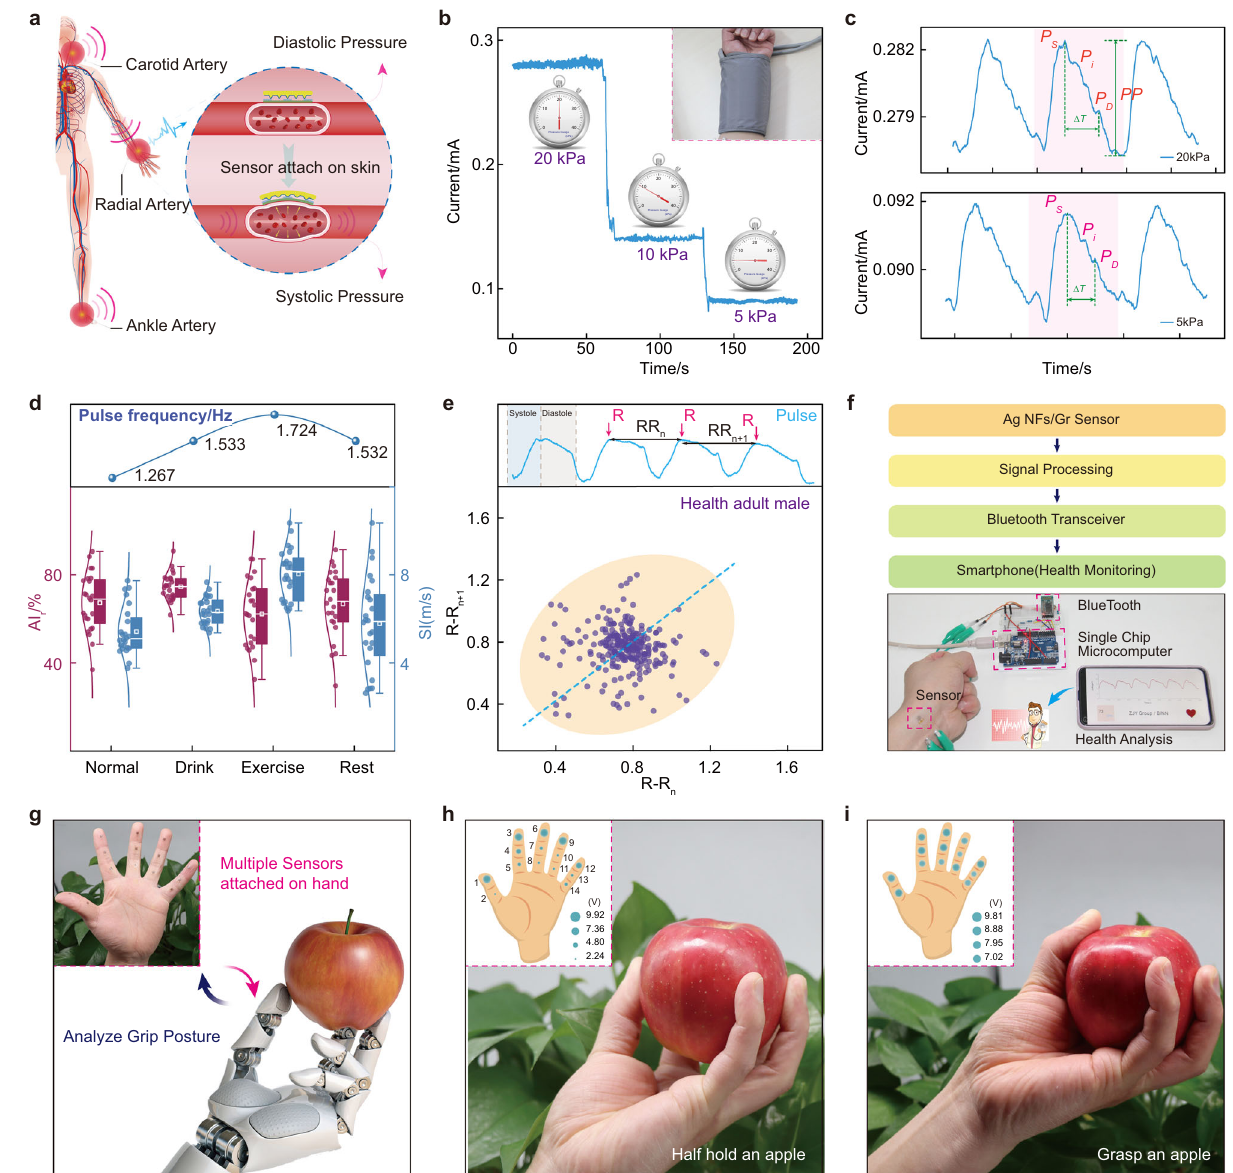
Fig. 4 | Real-time detection of human pulse and analysis of grasping posture. a Schematicdiagramofsensorsattachedtothevariousarteriesandtheprincipleto detect the systolic and diastolic pressure. b Pulse signal detected with different externalpressures.Inset:usingabloodpressurecufftoapplypressure. c Extracted interpreted pulse waveforms under the pressure of 20 and 5 kPa. d Augmentation index( AIx ),re fl ectionindex( RI ),andfrequencyofthepulsewaveformsindifferent states, including drinking, exercise, and rest. Top: Pulse frequency variation